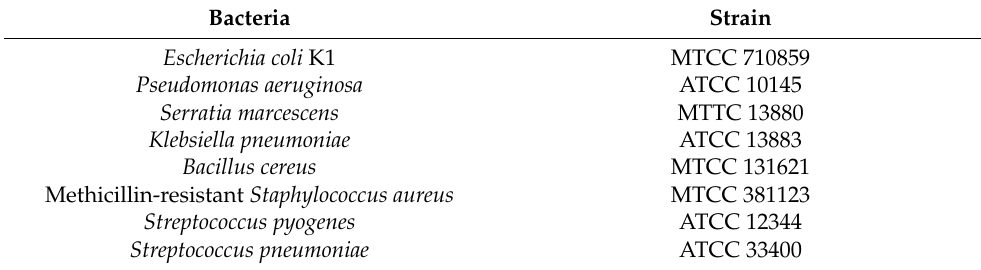
Table 2. Types of bacteria used in this study together with their strain and source. Bacteria